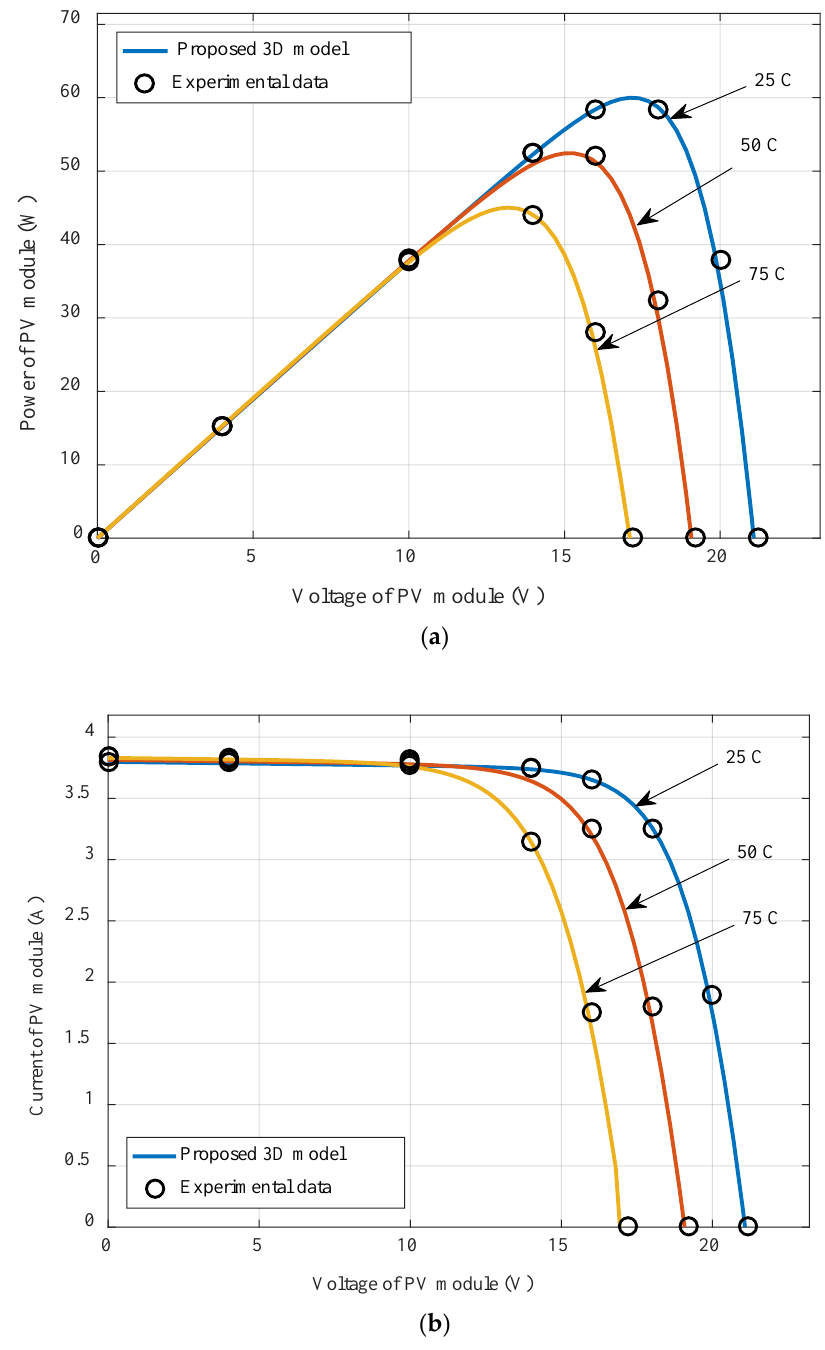
Figure 6. GOA-based simulation results and practical data of MSX-60 module at various temperature conditions, G = 1000 W / m 2 . ( a ) I-V curves. ( b ) P-V curves.